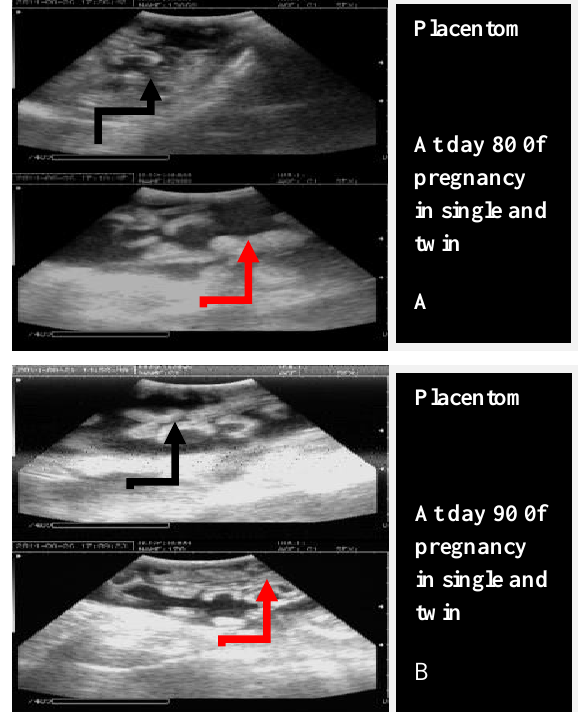
Figure, 5: Real time-B-mode Ultrasonography image of placentome of pregnant doe using transabdominal examination during 80 and 90 day of pregnancy in shami